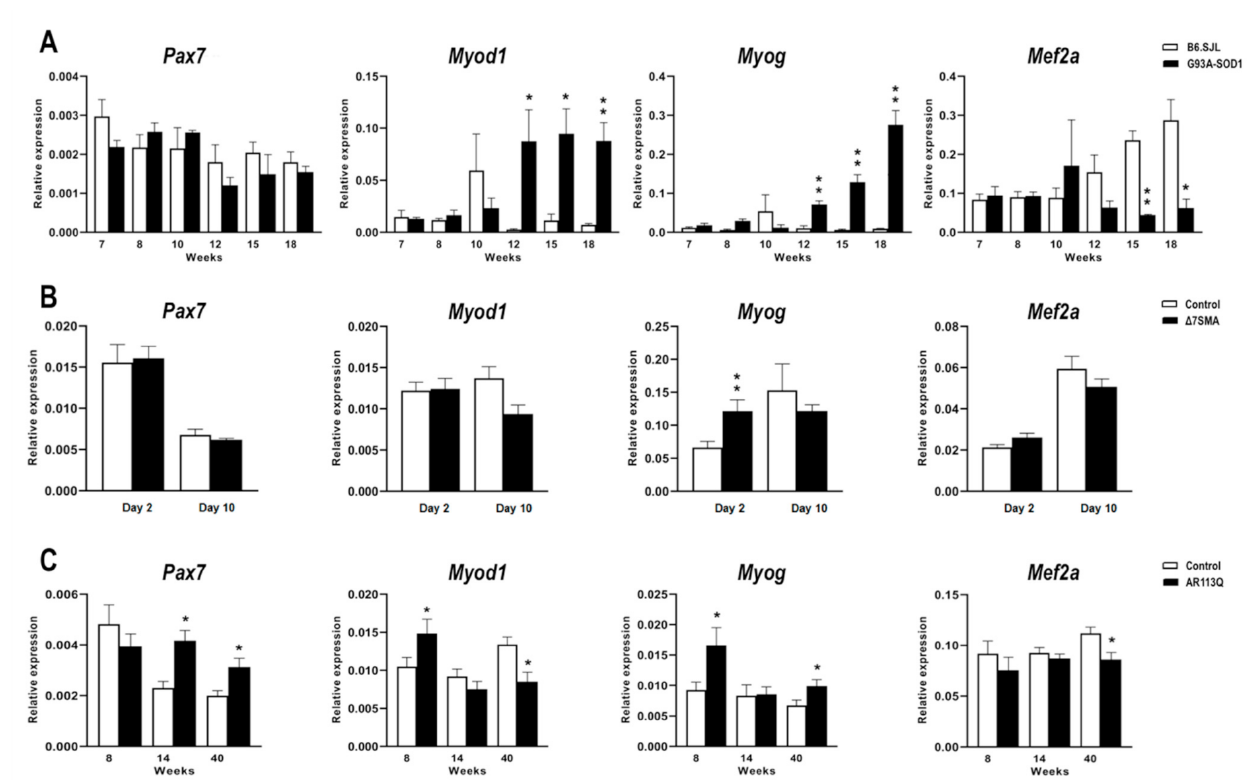
Figure 2. Expression levels of the predicted myomiR target genes in muscle tissue of MND and control animals obtained at different disease stage. Quantitative real-time PCR analysis of miRNA target genes, Pax7 , Myod1 , Myog , Mef2a in total RNA extracted from gastrocnemius muscle tissue of ( A ) G93A-SOD1 (black bars), ( B ) ∆ 7SMA (black bars), and ( C ) AR113Q (black bars) and control mice (white bars) ( n = 5 mice per group). Data were normalized to Rplp0 mRNA and expressed as 2 − ∆ Ct . Relative expression data are presented as mean ± SEM. * p < 0.05, ** p < 0.01, Mann–Whitney